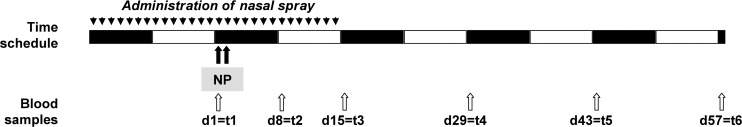
Study design.Patients administered nasal spray containing either nasal fluticasone propionate or placebo (black arrows) for 2 weeks before and after nasal allergen provocation (NP) performed on two consecutive days. Blood samples for measurement of allergen-specific antibodies (white arrows) were obtained at the time of the first nasal provocation (day 1 = t1) and on days 8 (t2), 15 (t3), 29 (t4), 43 (t5) and 57 (t6).